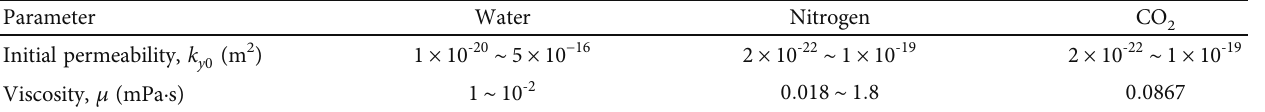
Table 4: Computational parameters for simulation of water and gas permeation.